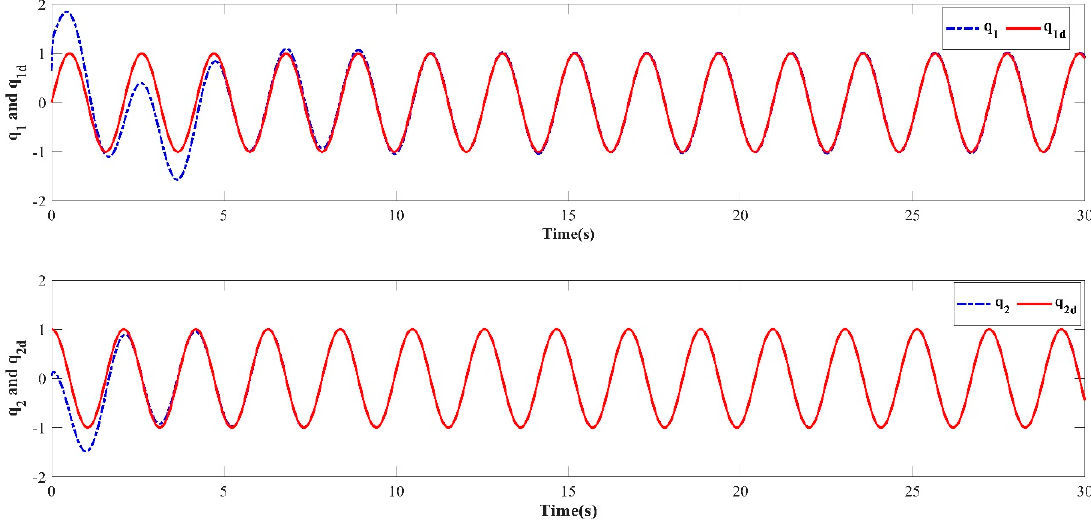
Figure 3 Learning trajectory in the first iteration. Figure 3. Learning trajectory in the first